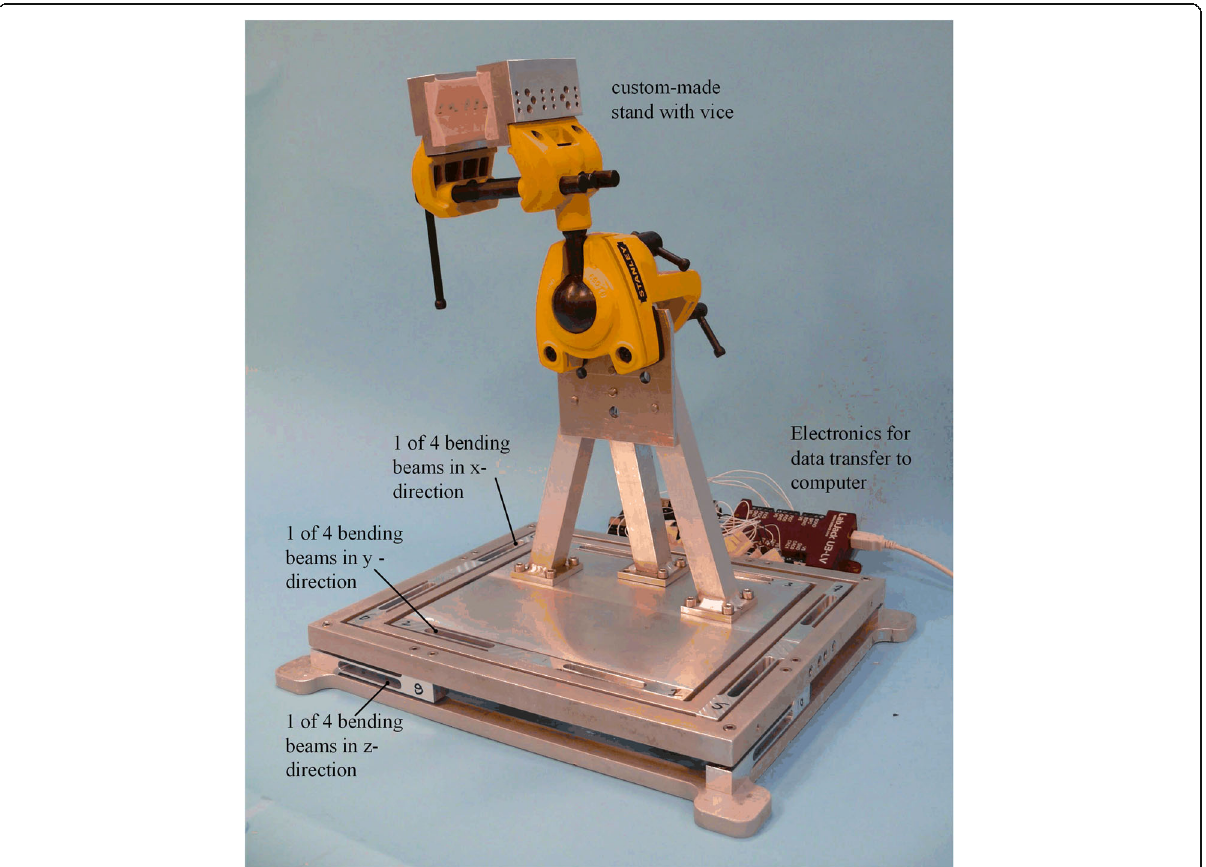
Fig. 1 Force Measurement Table. The FMT with custom-made stand with vice attached is shown. The FMT consists of the three squared frames and bending beams with Hall effect sensors and magnets in the x-, y- and z-plane of the FMT. The design of the FMT allows continuous recordings of the forces exerted on the cadaver specimen attached to the vice in three loading directions